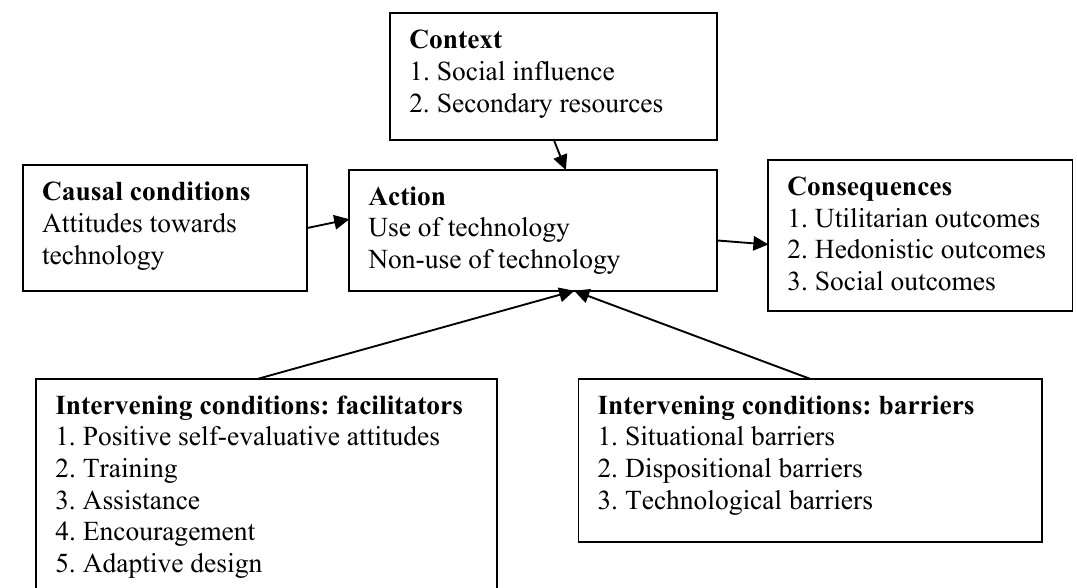
Figure 1. Result of the axial coding—relationships between